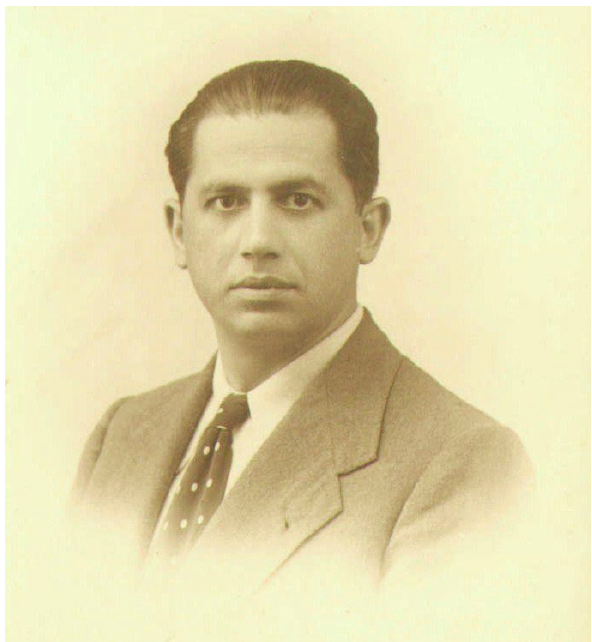
Figure 5. Zvi Enrico Jolles in the passport photo of 1938; (from the private collection of the Jolles-Bainbridge family, now in the Fondo Jolles at Florence University Museum of Natural